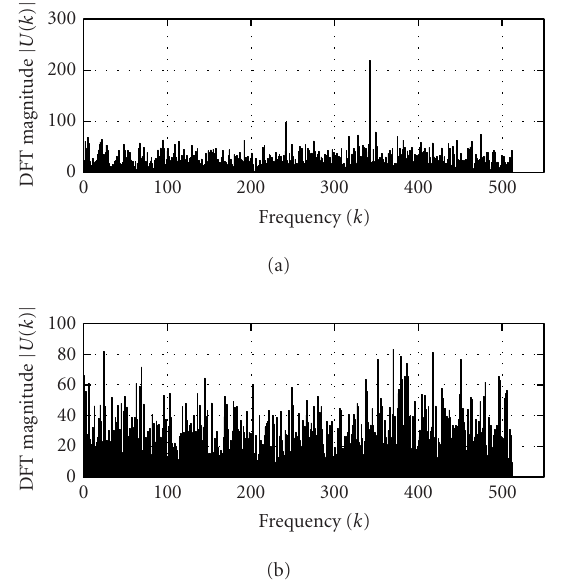
Figure 1. Representative DFT magnitudes for (a) coding and (b) noncoding regions in yeast chromosome I.